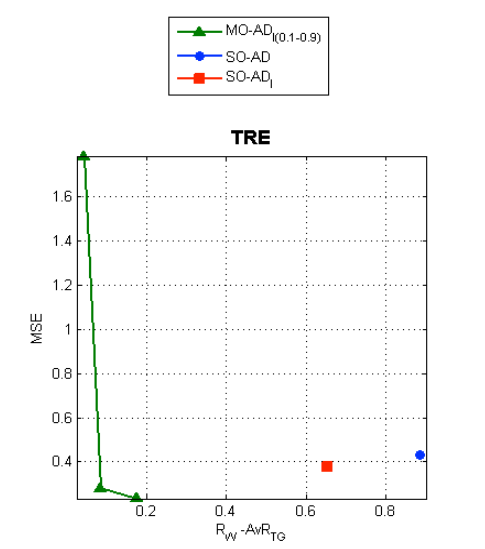
Fig. 3. Average pareto fronts obtained for TRE data sets in the accuracy-interpretability plane using WM rule